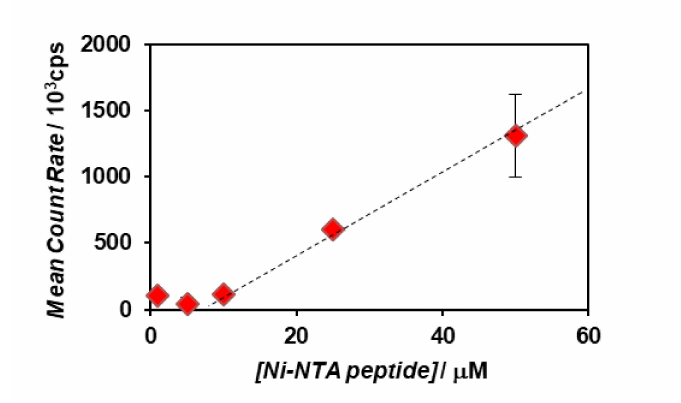
Figure 4. E ff ect of the concentration of β -annulus peptide modified with Ni-NTA on scattering intensity determined by DLS at 25 ◦ C in a 10 mM Tris-HCl bu ff er (pH 7.2).